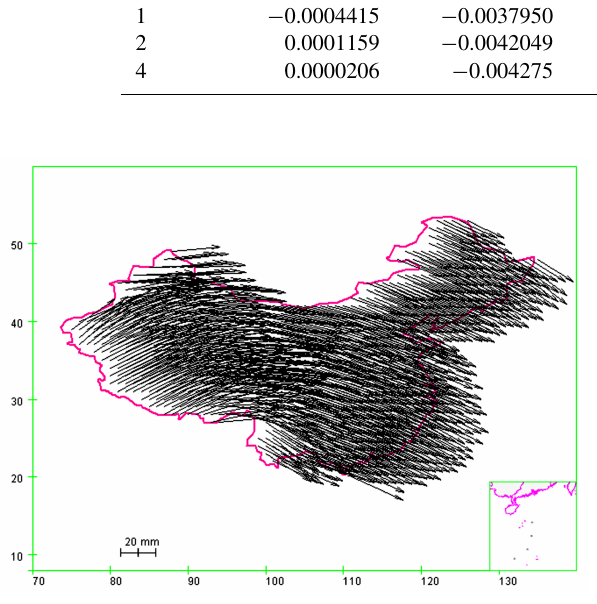
Figure 3. 1 ◦ × 1 ◦ velocity field model deducting the Chinese con- tinental crustal deformation background